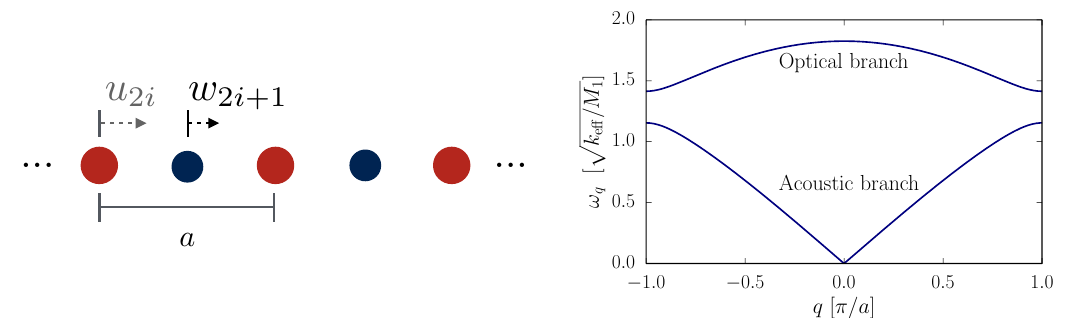
Figure 10: ( left ) A 1D lattice of atoms of mass M ments from equilibrium u longitudinal optical phonon branch. ( right ) The dispersion relations are shown over the first Brillouin Zone for M